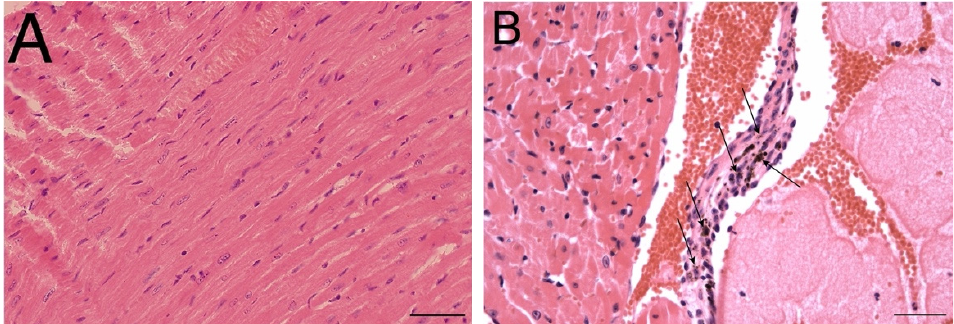
Figure 6. Histopathological effects of GPs on the heart tissue of C57Bl/6 mice after 21 days. Repre- sentative photomicrographs of control mice group ( A ) and ( B ) mice exposed 50 μ g/mL of GPs. Ar- rows indicate the accumulation of GPs in the endocardium of the heart. Cardiomyocytes in the con- trol group have physiological morphology. The scale bar ( A ) = 50 μ m, ( B ) = 20 μ m; staining haema- toxylin-eosin.